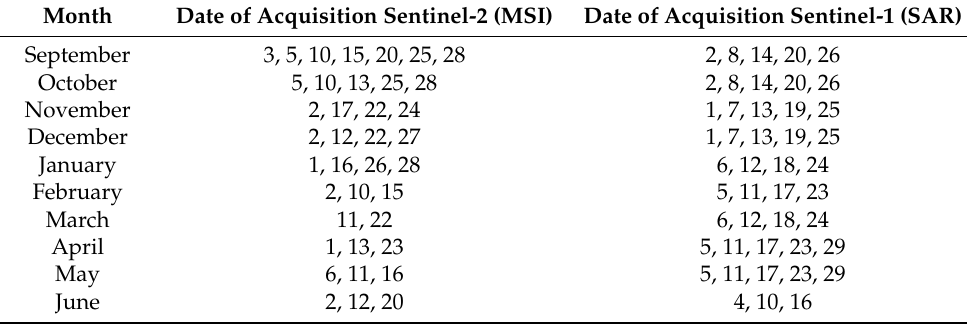
Table 3. Date of acquisition of Sentinel-2 and Sentinel-1 from September 2020 to March 2021. Month